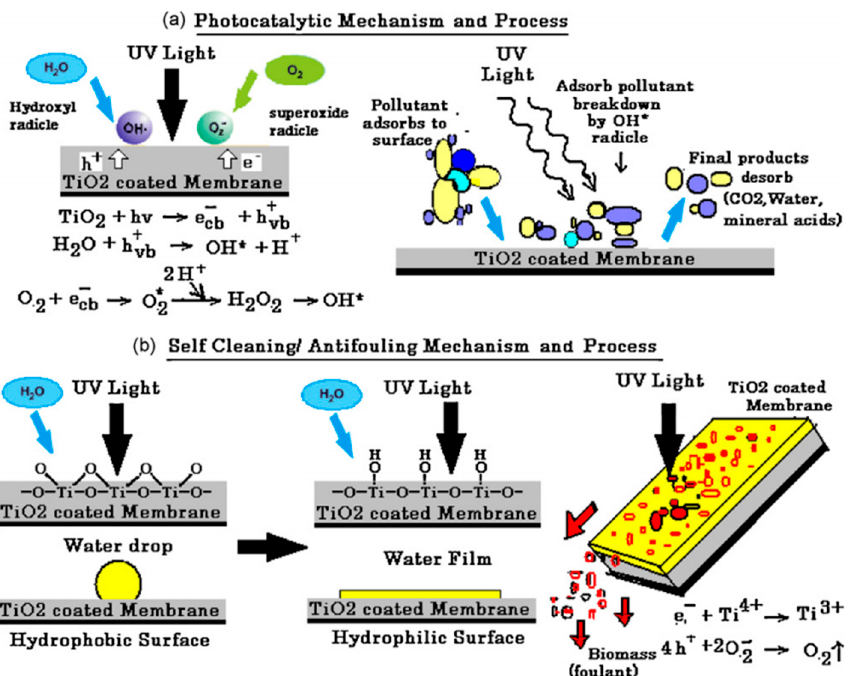
Figure 13. Demonstration of the ( a ) photocatalysis mechanism and process as well as ( b ) Self-cleaning/antifouling mechanism and process of polyvinylidene fluoride (PVDF)/TiO 2 membrane. Reprinted from [131] with permission from Elsevier.